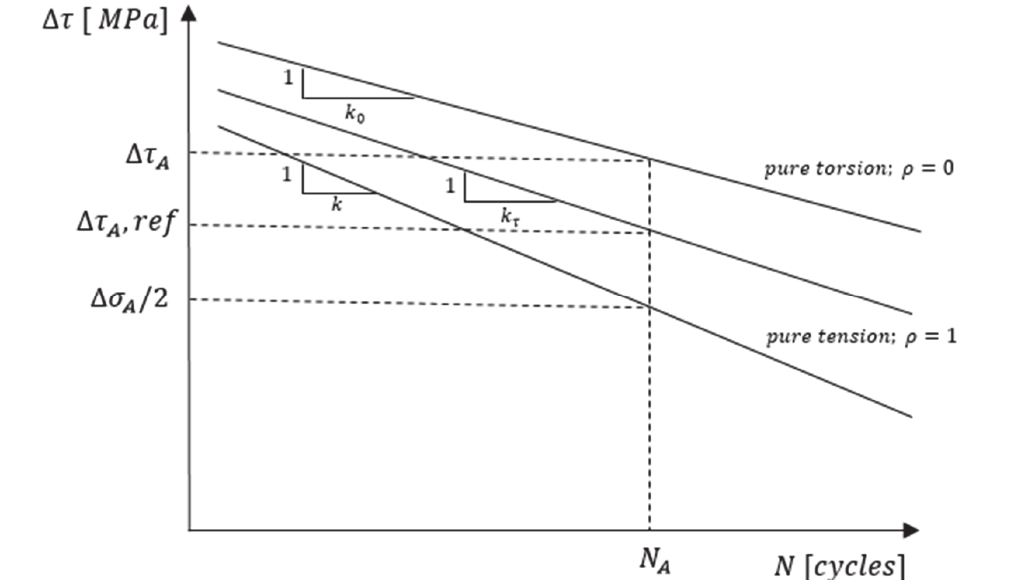
Figure 4: Constructing a load specific SN-curve using the curves for pure uniaxial and torsional loading following the Modified Wohler Curve Method; Reproduced from [9].